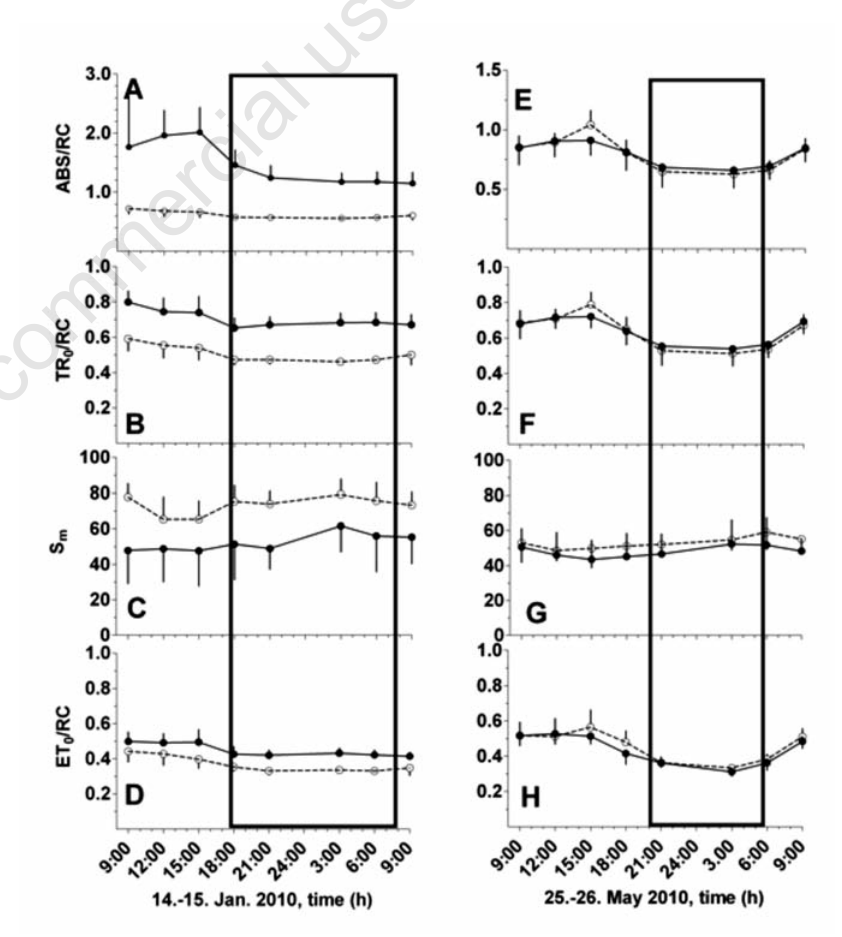
Figure 2. Diurnal courses of chl fluorescence parameters in Q. ilex growing outdoors ( ● , FR) or in a frost-free foliar greenhouse ( ○ , FRFF) at Frankfurt on 14.01.2010 (A-D) and on 25.05.2010 (E-H). FR, Frankfurt; FRFF, Frankfurt, frost-free (see also Figure 1).